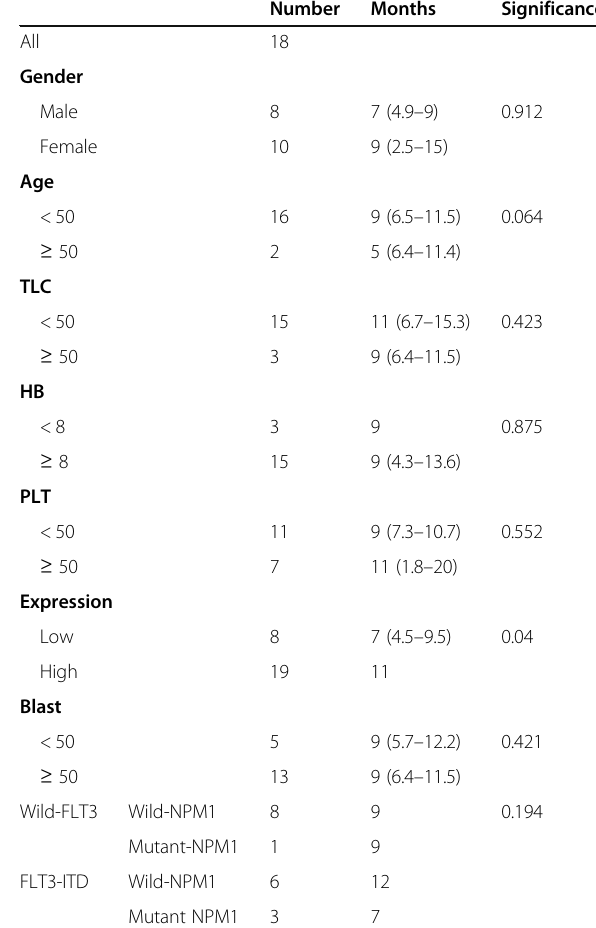
Table 7 Relapse-free